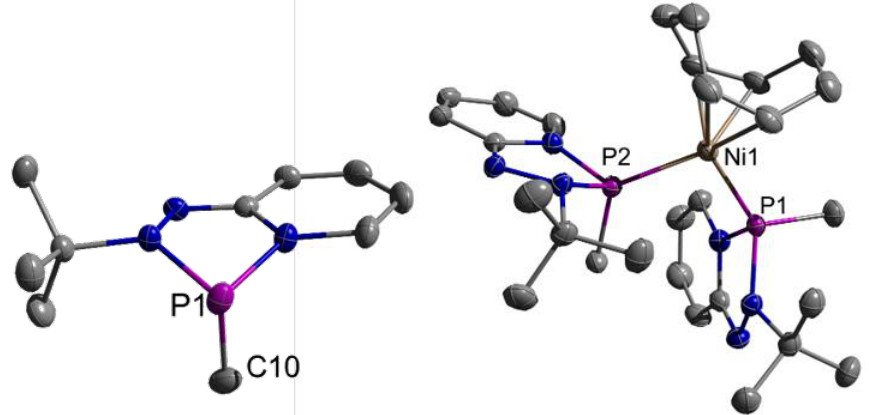
Figure 3. Representation of the molecular structures of 4 ( left ) and 5 ( right ) in the crystal. Hydrogen atoms were omitted for clarity. Thermal ellipsoids were drawn at the 50% probability level. Selected distances are listed in Tables 1 and S2.